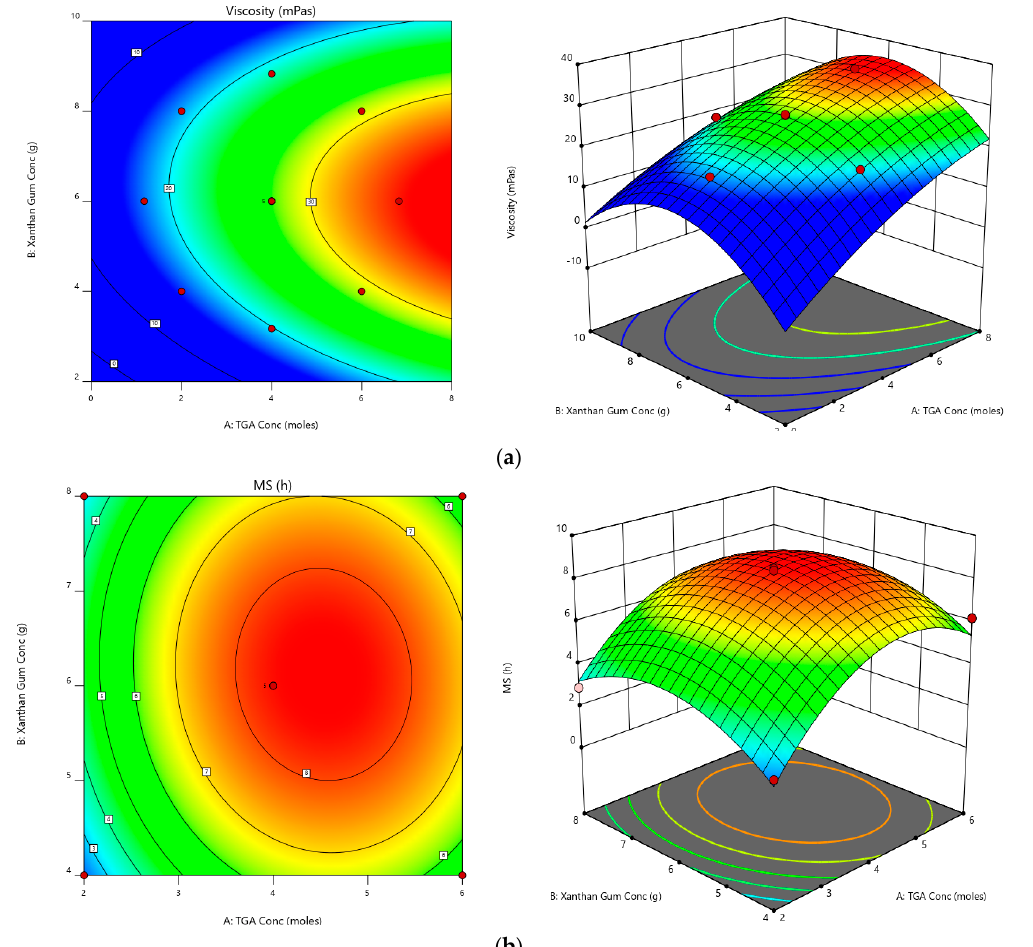
Figure 2. Contour plots and 3 ‐ D response surface graphs for ( a ) viscosity and ( b ) MS. Optimizing different series of models obtained from the experimental analysis can be carried out by applying the desirability function [D]. Each response was set to various limits; both the responses were set to maximum to plot the overlay graph [51,52]. All the selected variables were involved in the design space. The combined desirability plot for all the responses showed a maximum D value of 0.883 [Figure 3], which was obtained at optimum concentrations of independent variables, and the critical responses were over ‐ layed in a contour plot. Based on this desirability approach, a TXG prepared using 5.303